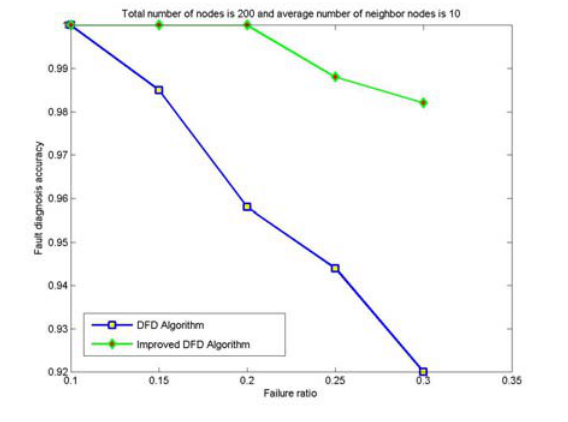
Figure 4. The node fault detection accuracy with various node failure ratios when 200 nodes are randomly deployed and the average numbers of neighbor nodes is 10.